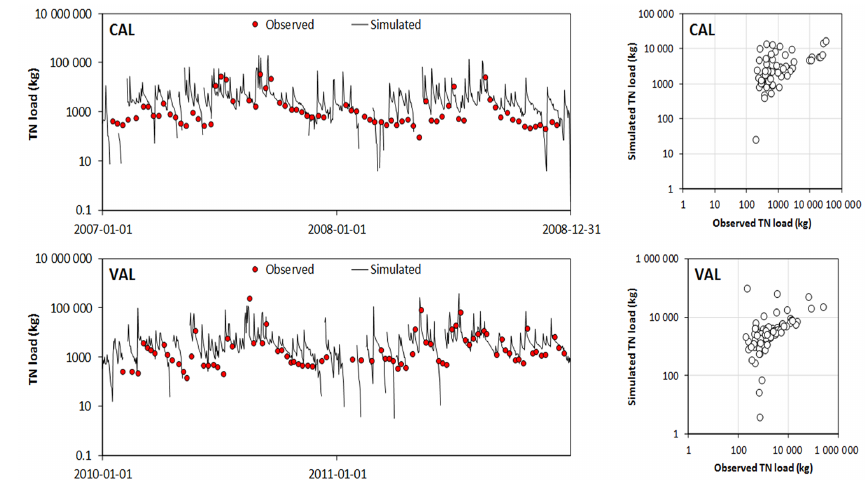
Figure 6. Comparison of simulated and observed total nitrogen (TN) load for calibration (top) and validation (bottom)